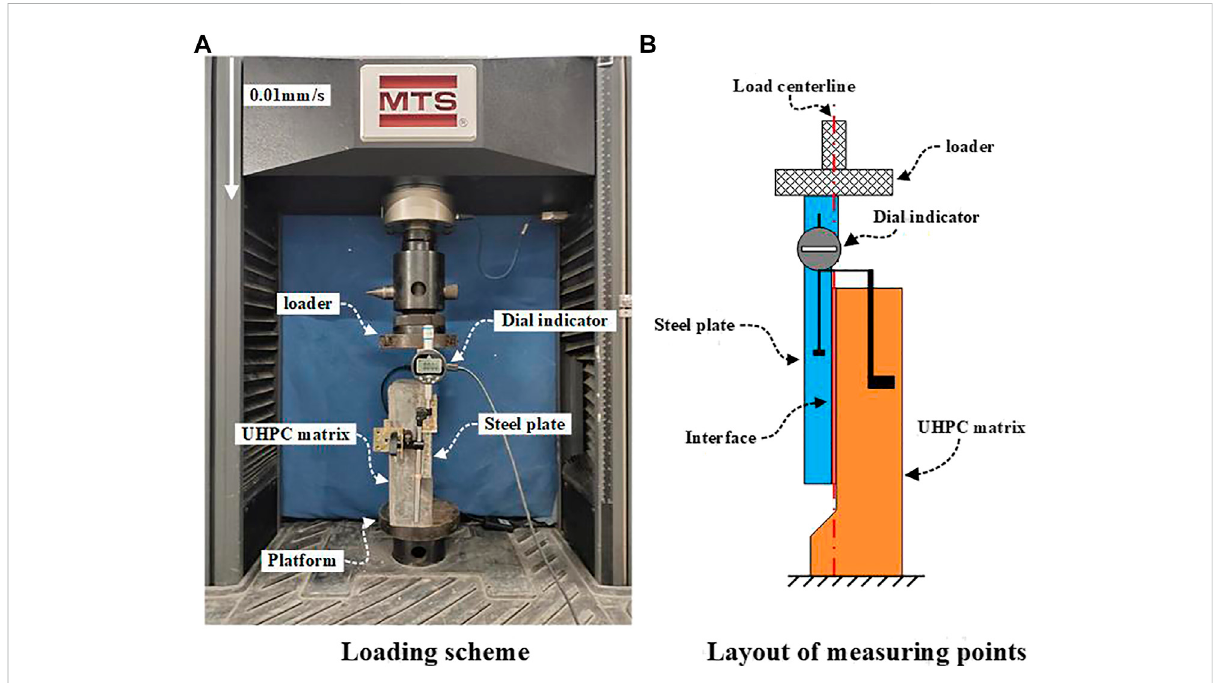
FIGURE 2 Interface test scheme. (A) Loading scheme. (B) Layout of measuring